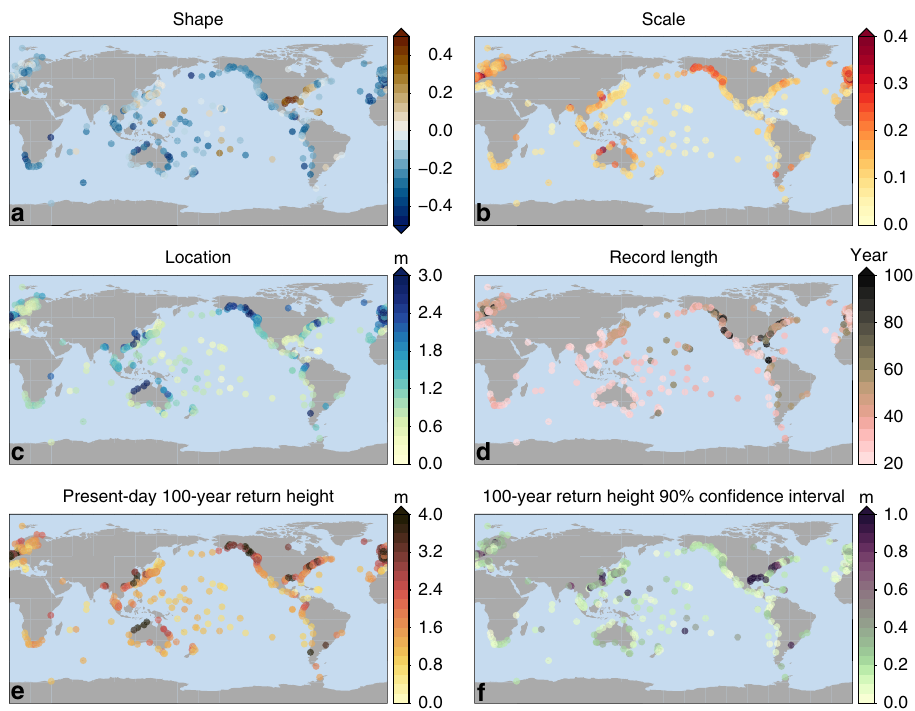
Fig. 3 Properties of the tide-gauge sites. The shape ( a ), scale ( b ), and location ( c ) parameters of the GPD distribution, the record length, expressed in the number of unique years in each record ( d ), the present-day 100-year return height ( e ), and its uncertainty ( f ), expressed as the width of the 5 – 95% con fi dence interval. See Supplementary Fig. 5 for the con fi dence intervals for the shape and scale